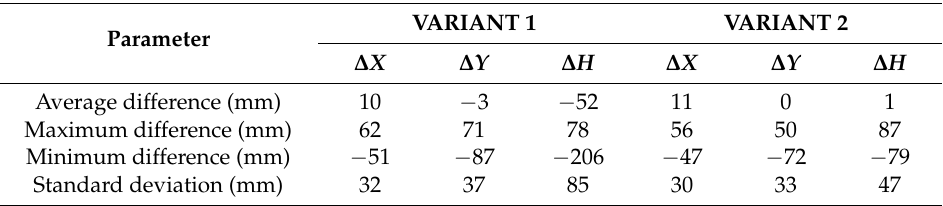
Table 9. Average differences in coordinates and their maximum and minimum values for check points surveyed using RTK GNSS, compared to an aligned block of